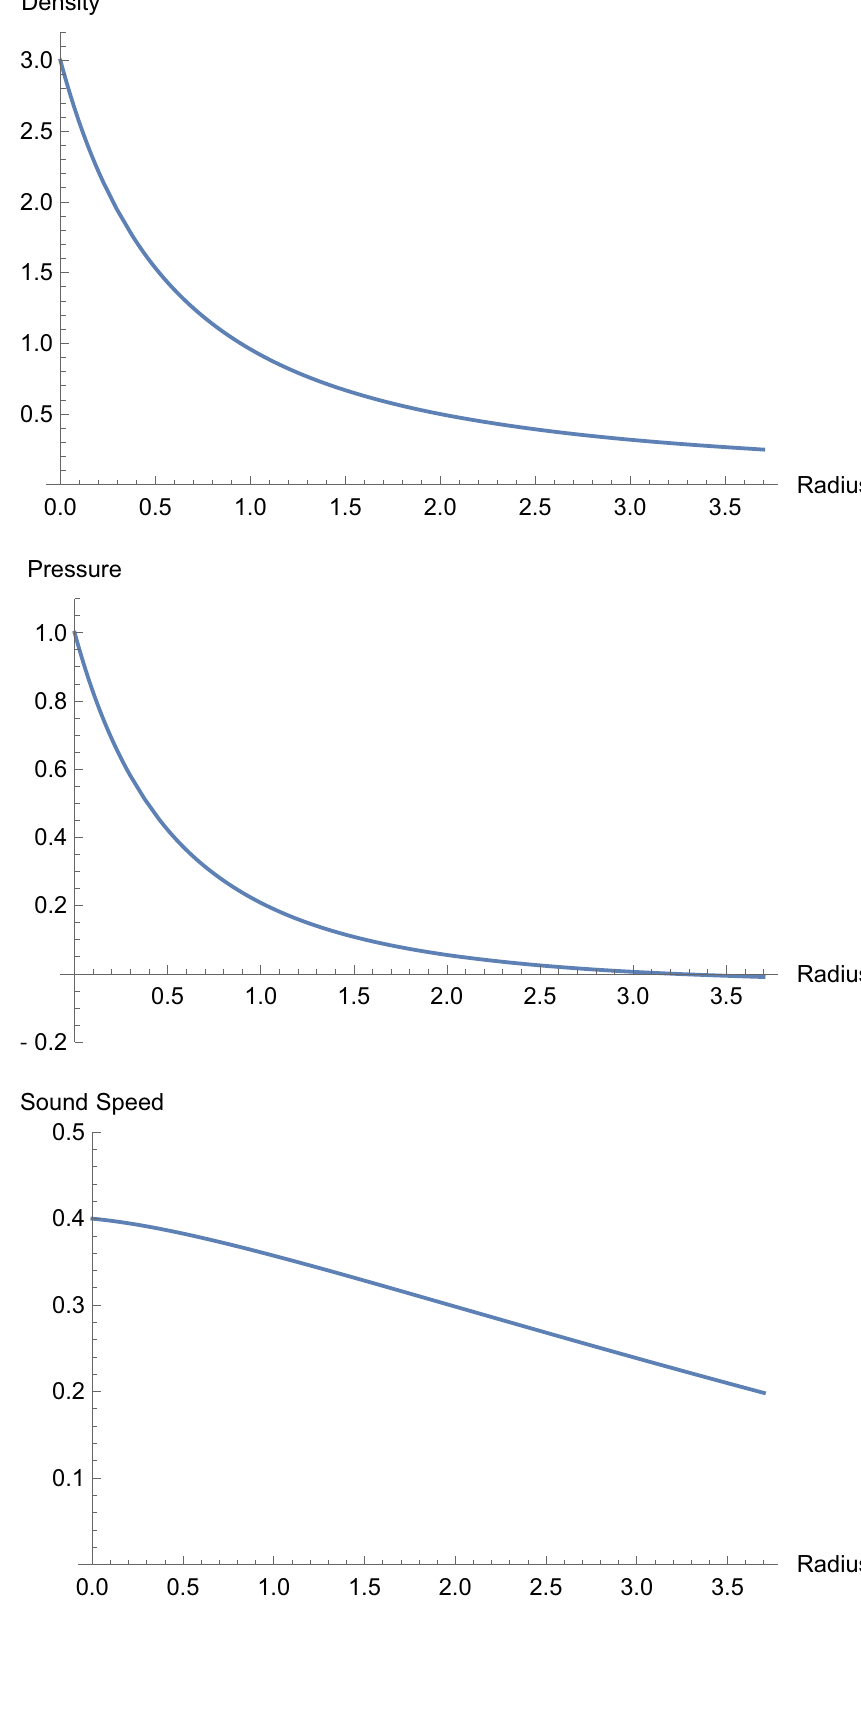
Fig. 1 Density ρ versus the radial variable x